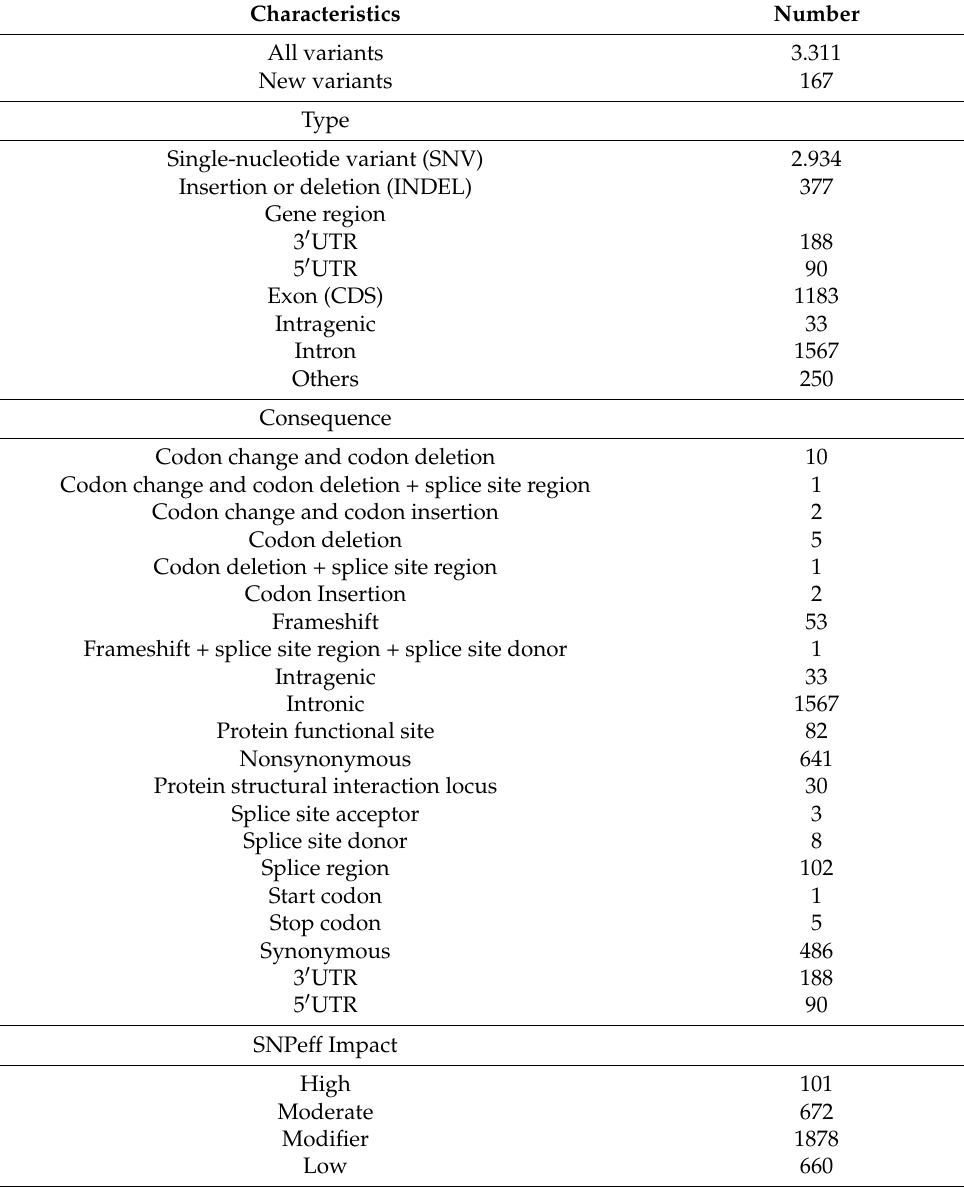
Table 1. Description of all variants found in the exome of 64 Amazonian Amerindians of the